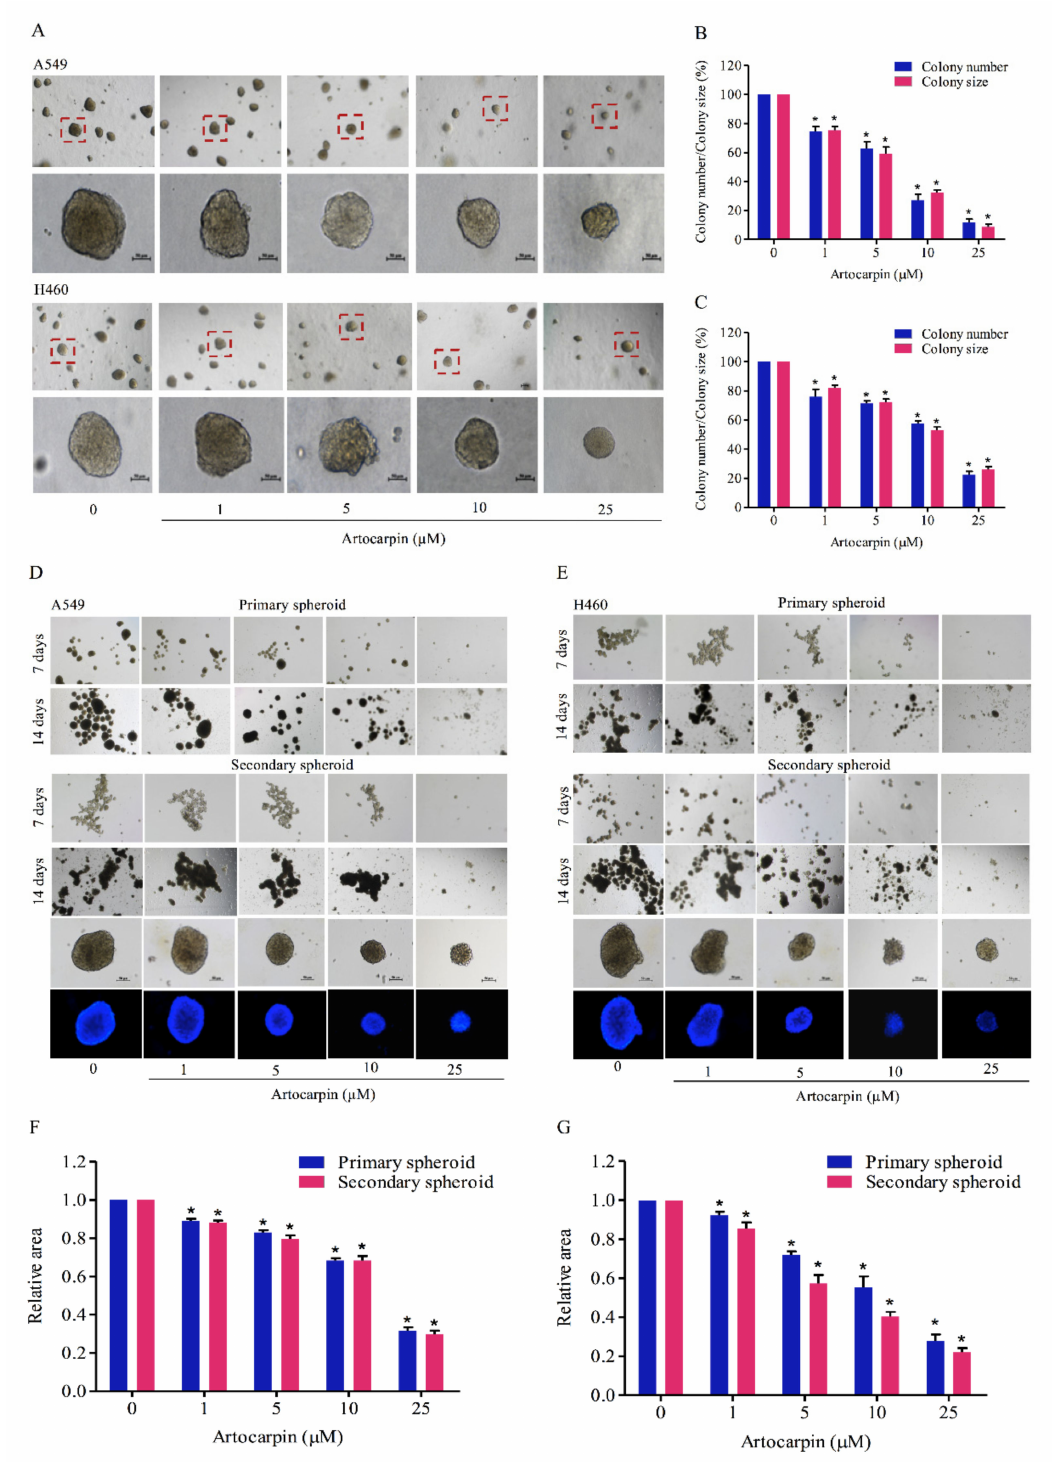
Figure 3. Artocarpin suppresses anchorage-independent growth and cancer stem cell (CSC)-like phenotypes of lung cancer cells. ( A – C ) A549 and H460 cells were pre-treated with non-toxic doses of artocarpin (0–10 µ M) and a toxic dose (25 µ M) at 37 ◦ C for 24 h, and were assigned to an anchorage-independent growth assay for 2 weeks. ( D – G ) Cells were treated with artocarpin (0–25 µ M) for 24 h, and the cells were suspended and allowed to form primary spheroids for 14 days. After dissociation of the primary spheroids, the cells were allowed to form secondary spheroids. Next, the spheroid of cancer stem cell (CSC)-rich population was investigated. All data are represented as mean ± SD ( n = 3). * p < 0.05, versus the non-treated